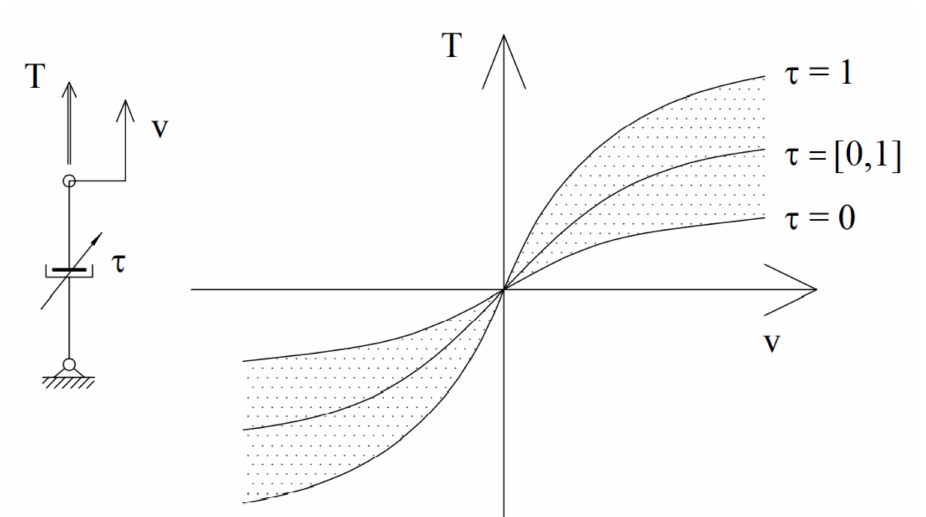
Figure 6. Schematic plot of dissipative characteristic of the semi-active damper T = f ( v; τ ) ; T —friction force, v —velocity of damper deformation, τ —damping